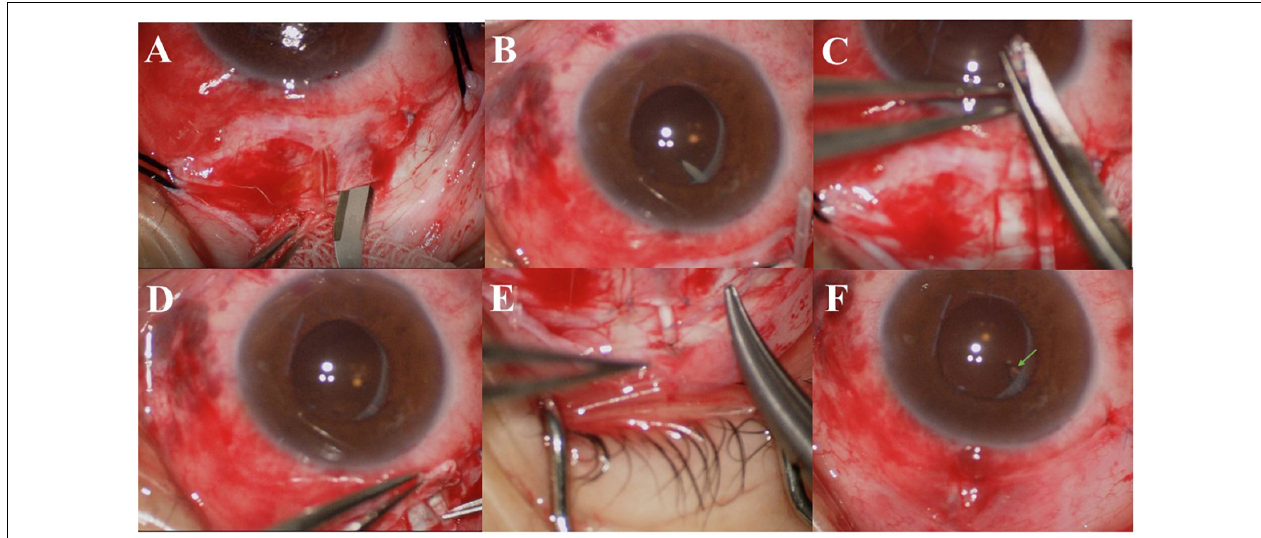
FIGURE 1 | (A) A rectangular, limbal-based half-thickness scleral flap was created. (B) The vitreous cavity was accessed using a 22-gauge needle at 3.5–4 mm behind the corneal limbus under the scleral flap. (C) The tube length was trimmed. (D) The tube was placed into the vitreous cavity at 3–4 mm through the needle track, and the tube inside the vitreous chamber can be seen under the dilated pupil. (E) The drainage tube after the scleral tunnel was fixed on the scleral surface using 8–0 Vicryl sutures. (F) The conjunctiva was sutured using 8–0 Vicryl sutures, and the tube (arrow) inside the vitreous chamber can be seen under the dilated